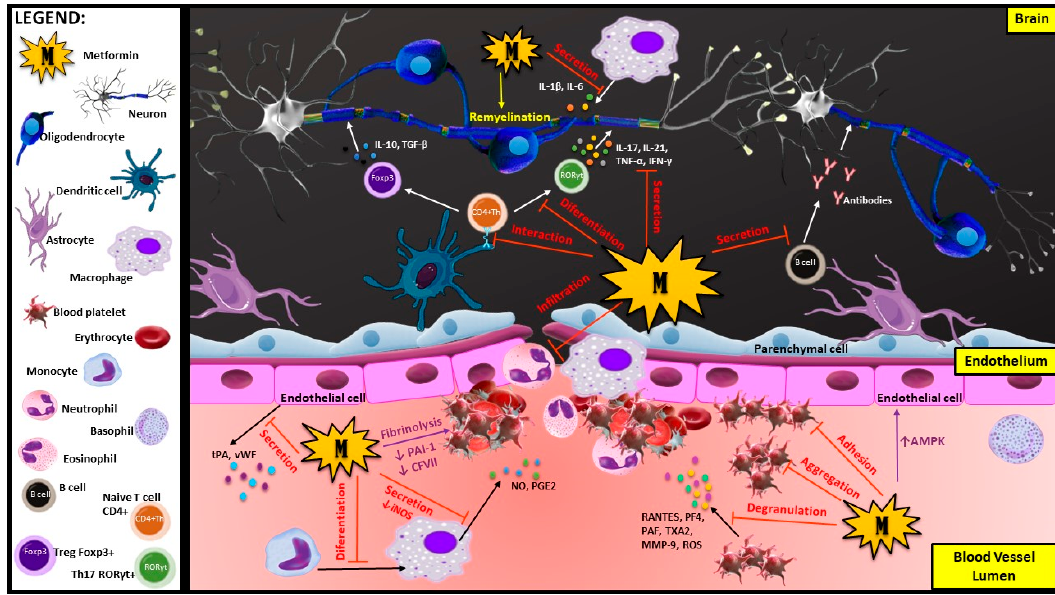
Figure 1. Actions of metformin on immune cells, blood platelets and endothelium during the development of neurodegeneration disease: Metformin has multiple properties such as anti-inflammatory, antioxidant and antithrombotic properties. It may influence different types of cells, including immune cells (oligodendrocytes, macrophages, T cells and B cells), blood platelets and endothelial cells. It may also affect many processes involved in BBB disruption and demyelination during MS development, including pro-inflammatory cell differentiation, degranulation and infiltration of immune cells into the CNS from the blood vessels, as well as myelin repair process